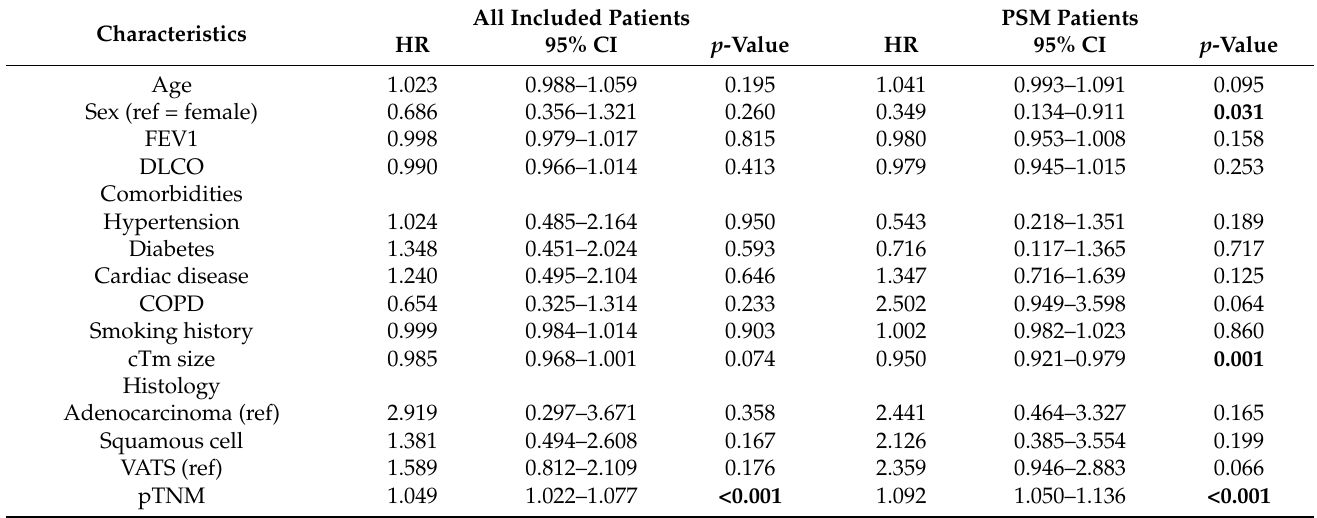
Table 5. Multivariable Cox proportional hazards analyses for